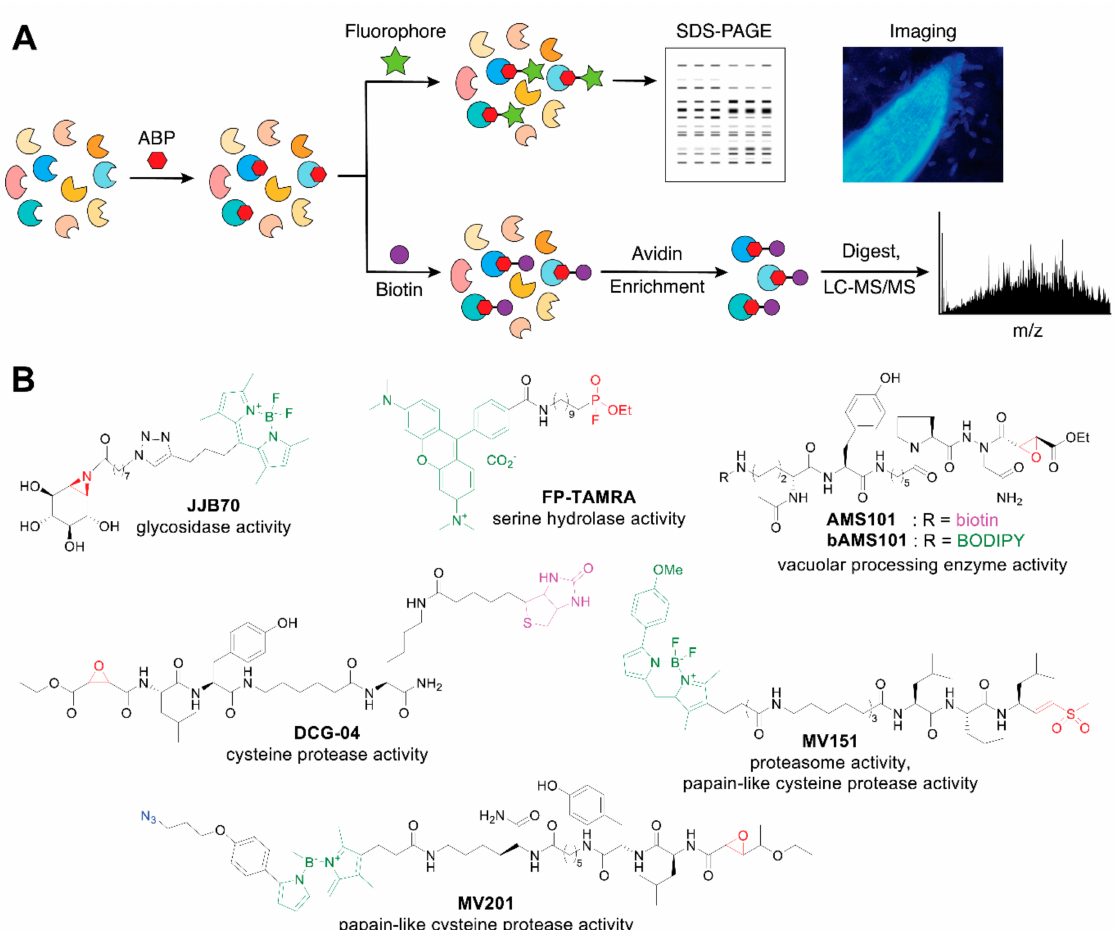
Figure 4. ( A ) Workflow for activity-based protein profiling using activity-based probes (ABPs; red hexagon) for covalent labeling of target proteins. Proteins labeled with fluorophore-conjugated ABPs can be analyzed by fluorescence gel electrophoresis or fluorescence microscopy. Enrichment of proteins labeled with biotin-conjugated ABPs, followed by trypsin digestion and liquid chromatography tandem mass spectrometry (LC-MS/MS) proteomics analysis, enables target identification. ( B ) Selected activity-based probes that have been applied to studying plant-microbe interactions. Functional activities targeted by each probe are shown below the probe names. Reactive groups are shown in red, click chemistry tags are shown in blue, fluorophores are shown in green, and affinity enrichment tags are shown in